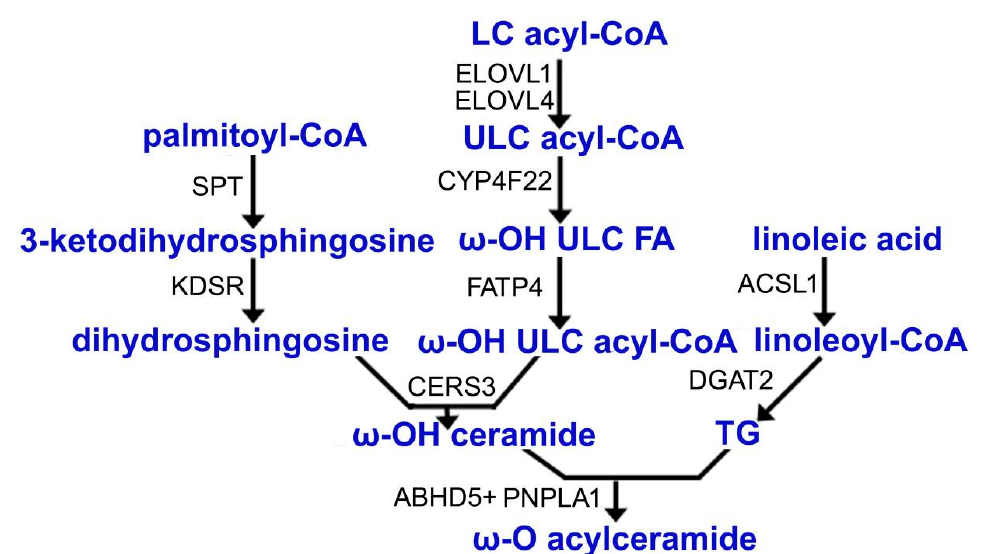
Figure 2. Acylceramide biosynthesis pathway. Metabolites and final products are marked in blue and the catalytic enzymes of each reaction are shown in black. The ω -O-acylation prior to ceramide synthesis remains uncertain. This figure tentatively shows that ω -O-acylation occurs after ω -OH ceramide production.